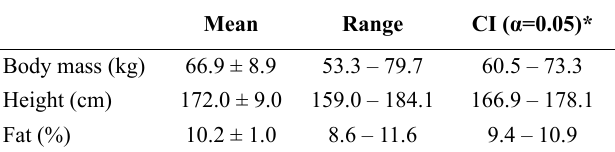
*Upper and lower confidence limits of confidence interval for mean. According to the FQ, 80% of athletes drank 1.5/2.0 l of water on a daily basis. All athletes denied the use of dietary supplements.